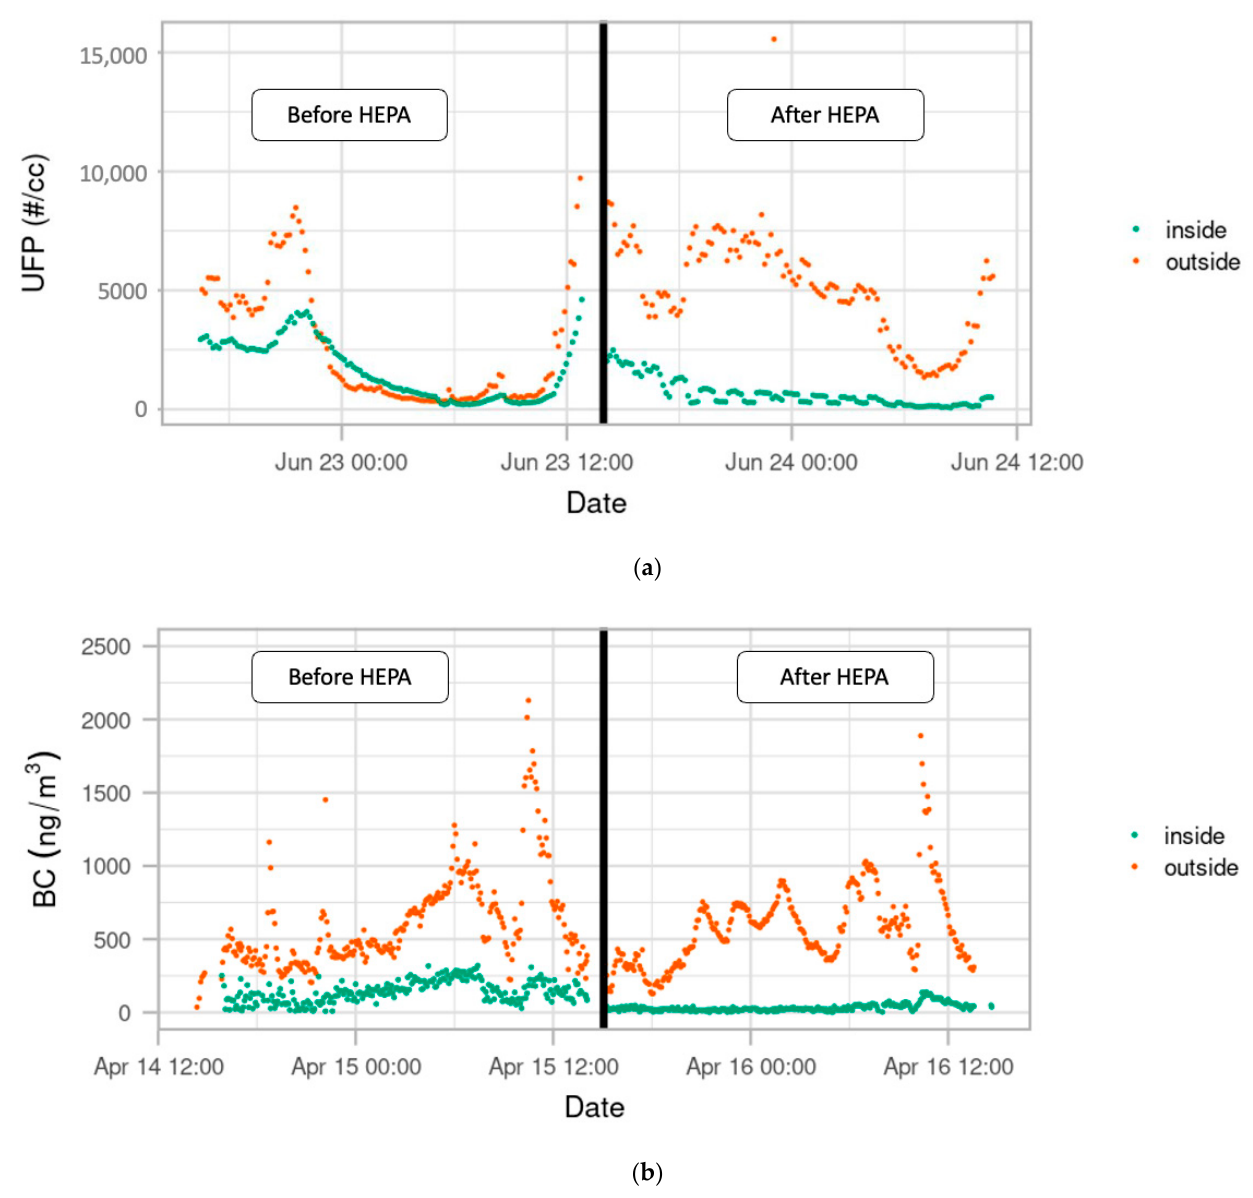
Figure 4. Indoor and Outdoor concentration of UFP Count and Black Carbon Particles at example schools. ( a ) Indoor and Outdoor concentration of total particle count before and after portable HEPA filter deployment. ( b ) Indoor and Outdoor concentration of Black Carbon before and after portable filter deployment.